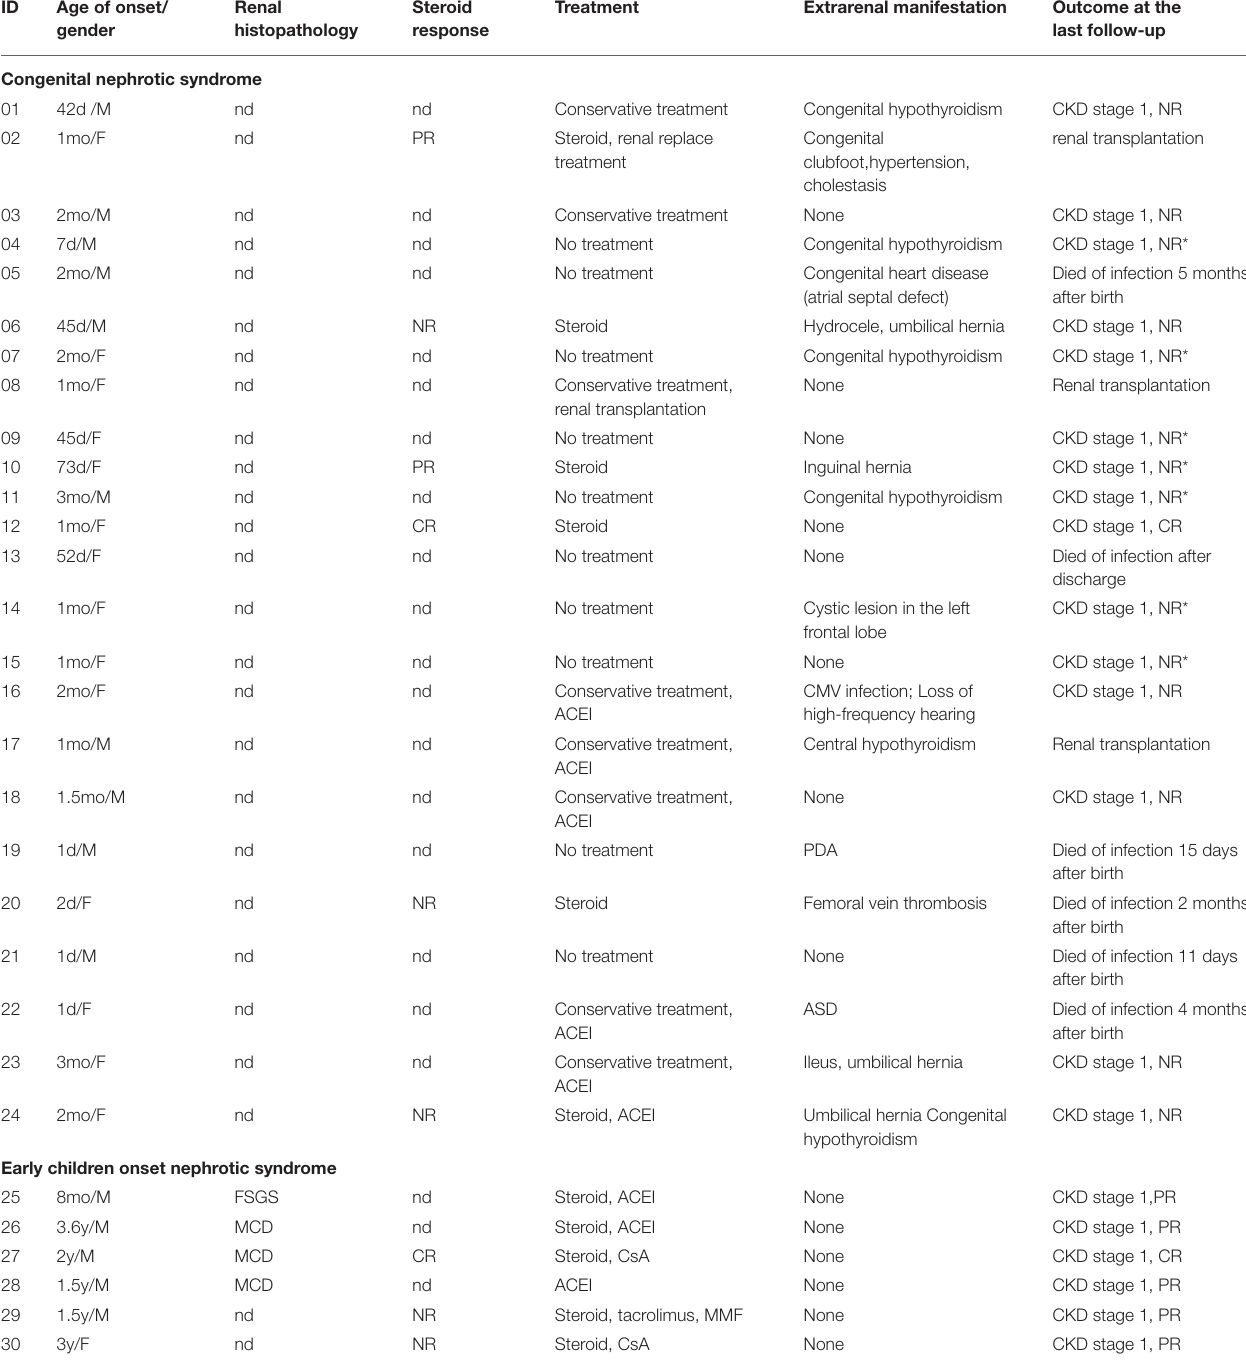
TABLE 1 | Clinical features and treatment for 30 patients with NPHS1 variants.